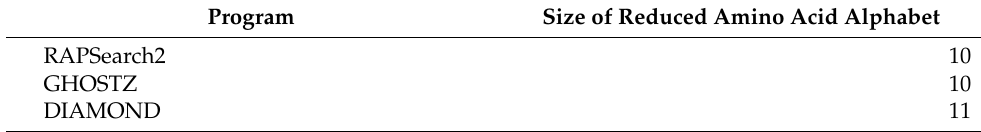
Table 2. Reduced amino acid alphabets used in comparison